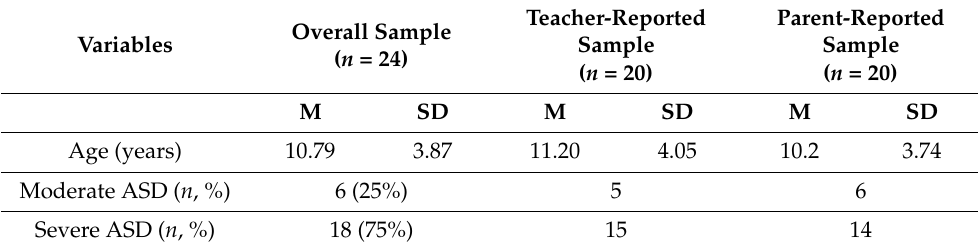
Table 2. Characteristics of study participants.